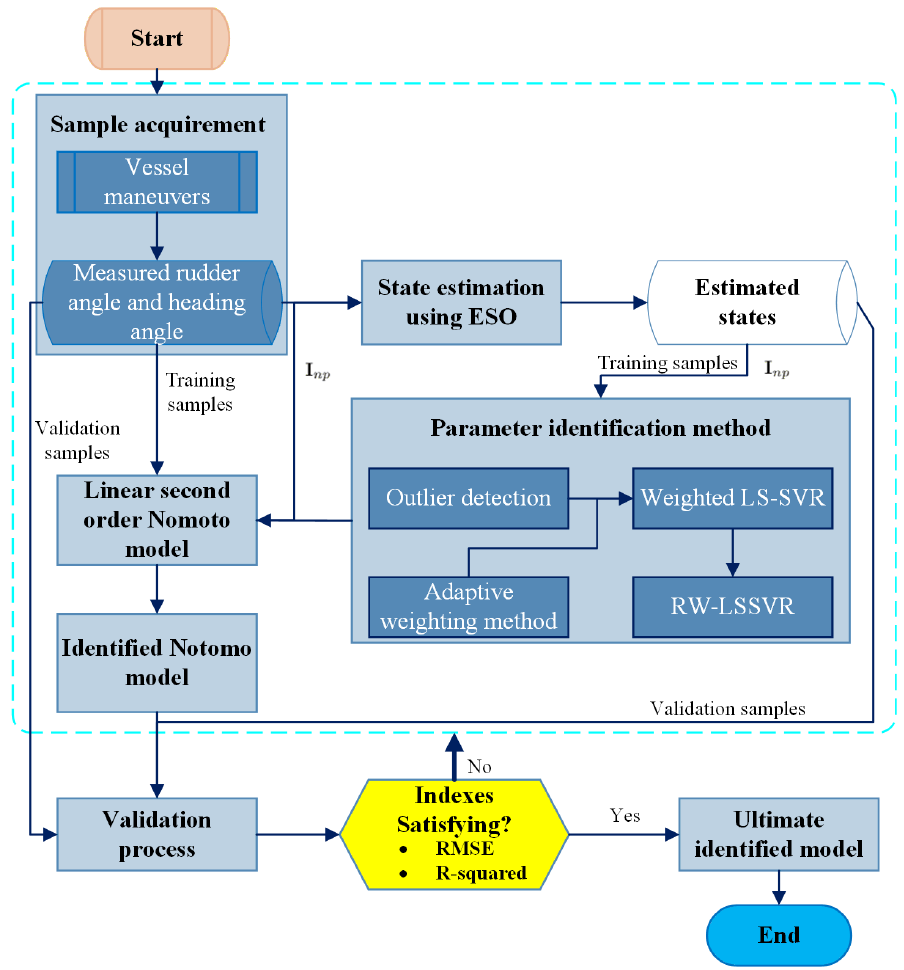
Figure 2. Identification procedure of the proposed hybrid identification